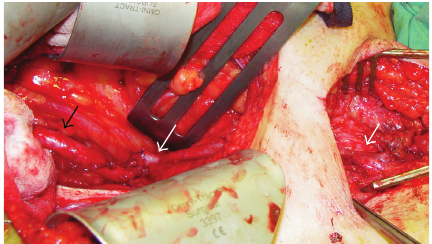
Figure2:Intraoperativephotographshowingtheveinbypass(white arrows) from the common iliac bifurcation (black arrow) to the common femoral artery